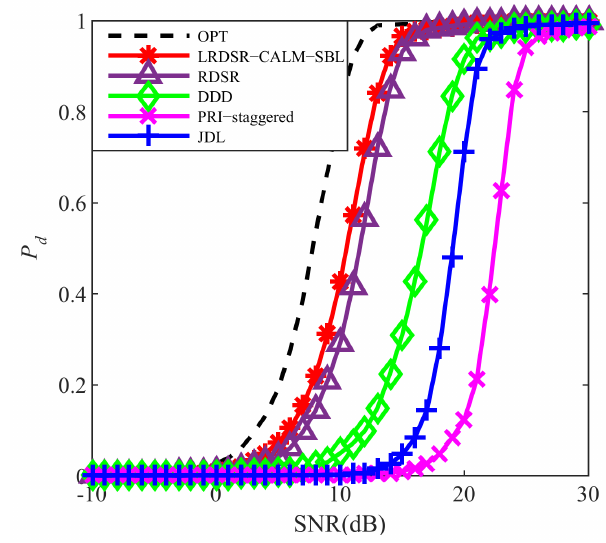
Figure 11. Probability of detection versus target